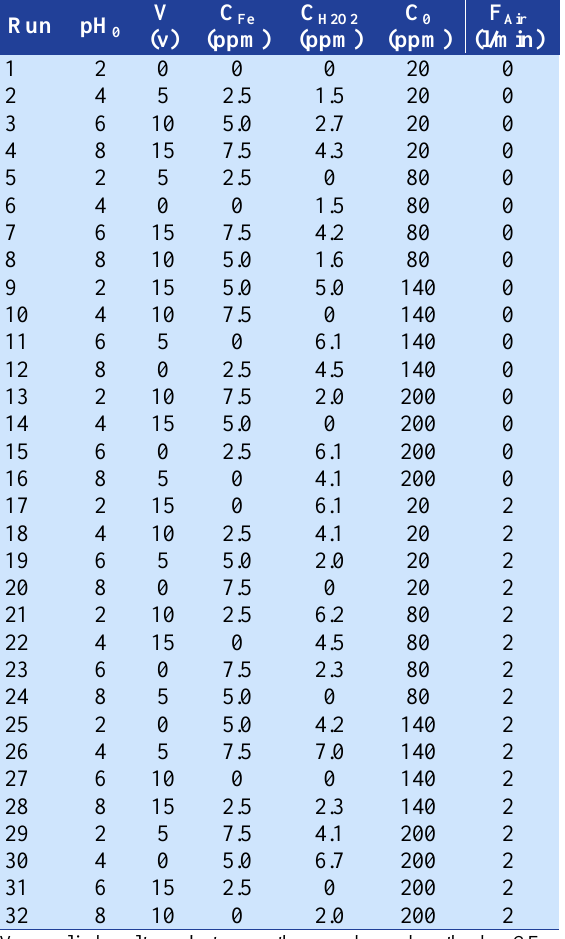
Table 2. The parameter levels for 32 runs.